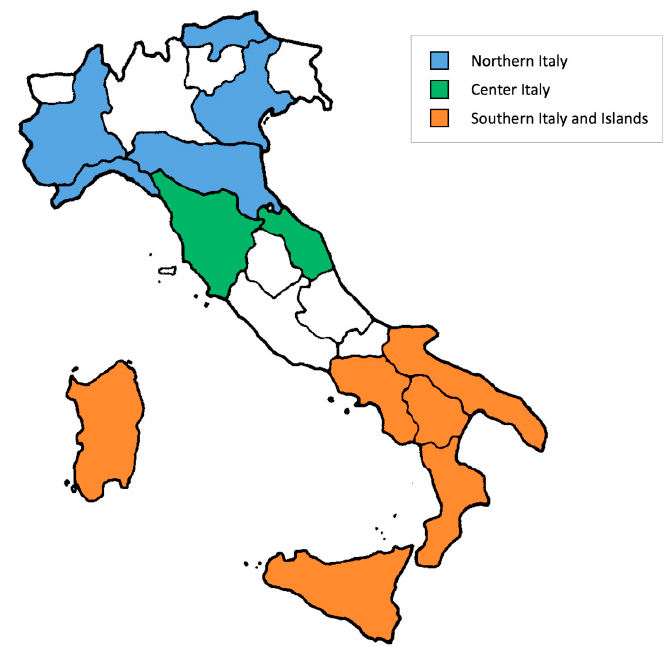
Figure 1. Regions participating in the study divided by geographical area.